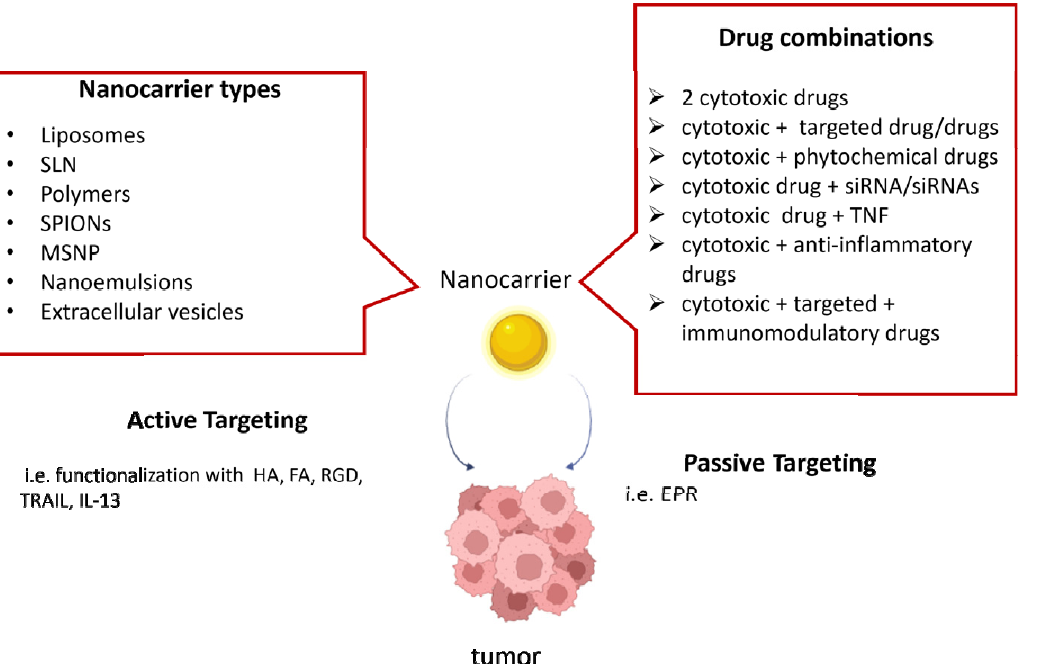
Figure 1. Combination therapy in nanomedicine. Several types of nanocarriers can be used: liposomes; solid lipid nanoparticles (SLN); polymeric nanoparticles (i.e., poly(ethylene gly ‐ col) ‐ block ‐ poly(2 ‐ methyl ‐ 2 ‐ benzoxycarbonylpropylene